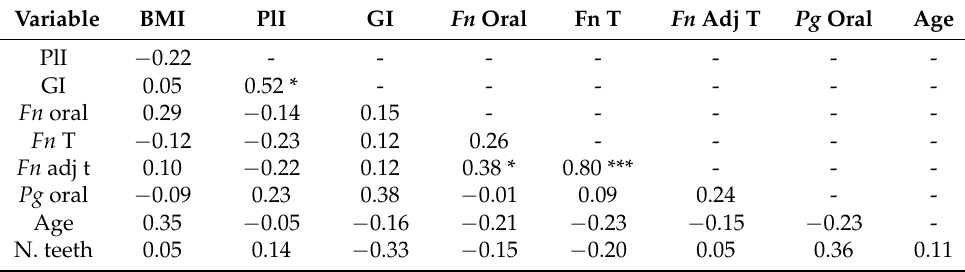
Table 3. Correlation matrices of the oral health parameters and Fn and Pg abundance. Rho coefficients were calculated with Spearman’s